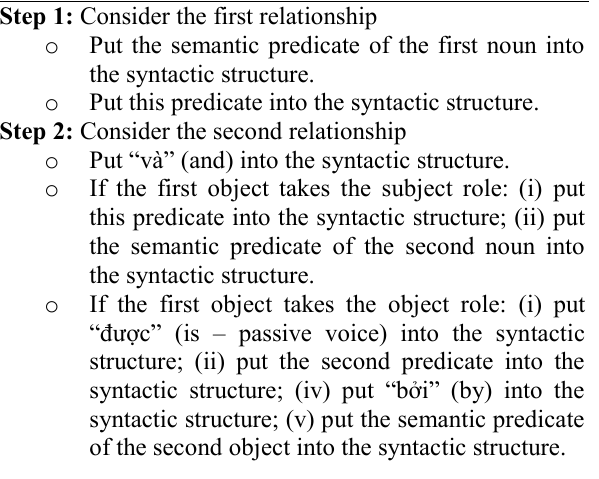
Algorithm 10 : Generate the syntactic structure of the new sentence for group